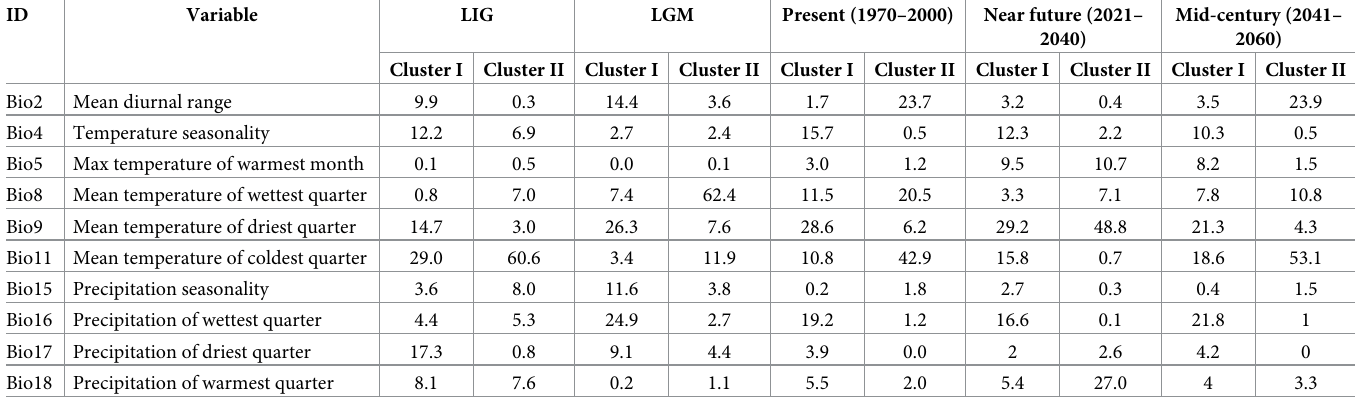
LIG = Last inter-glacial (120,000–140,000 years ago). LGM = Last glacial maximum (21,000 years ago).